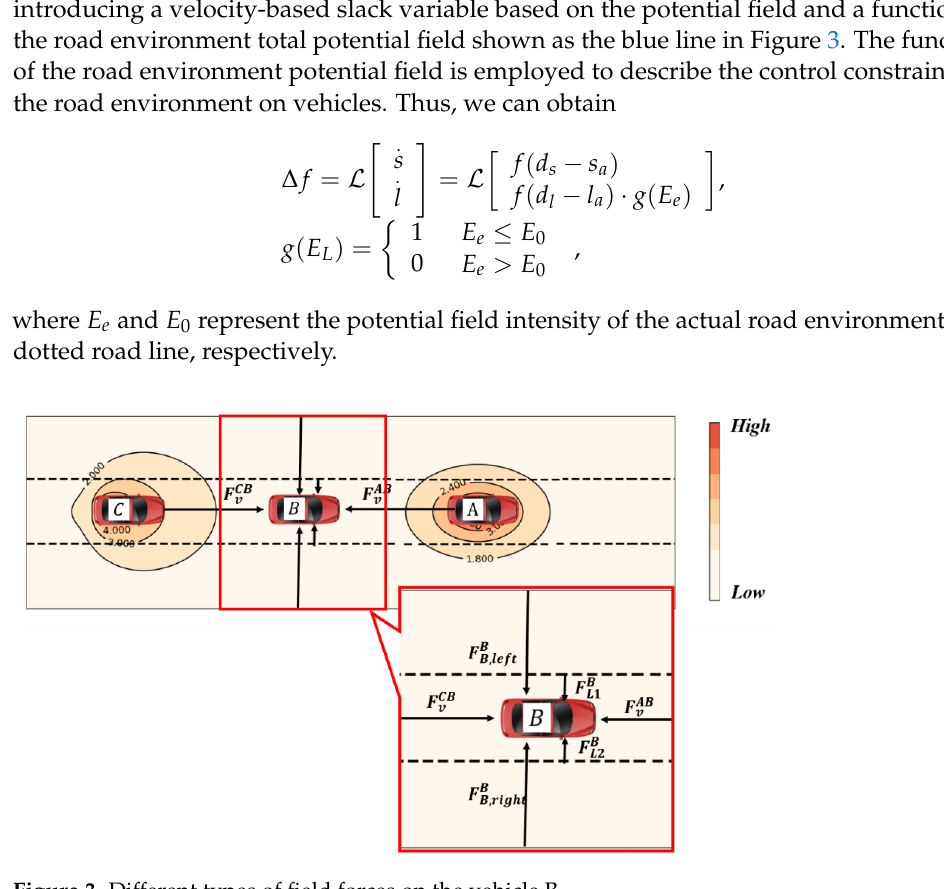
Figure 3. Different types of field forces on the vehicle B.